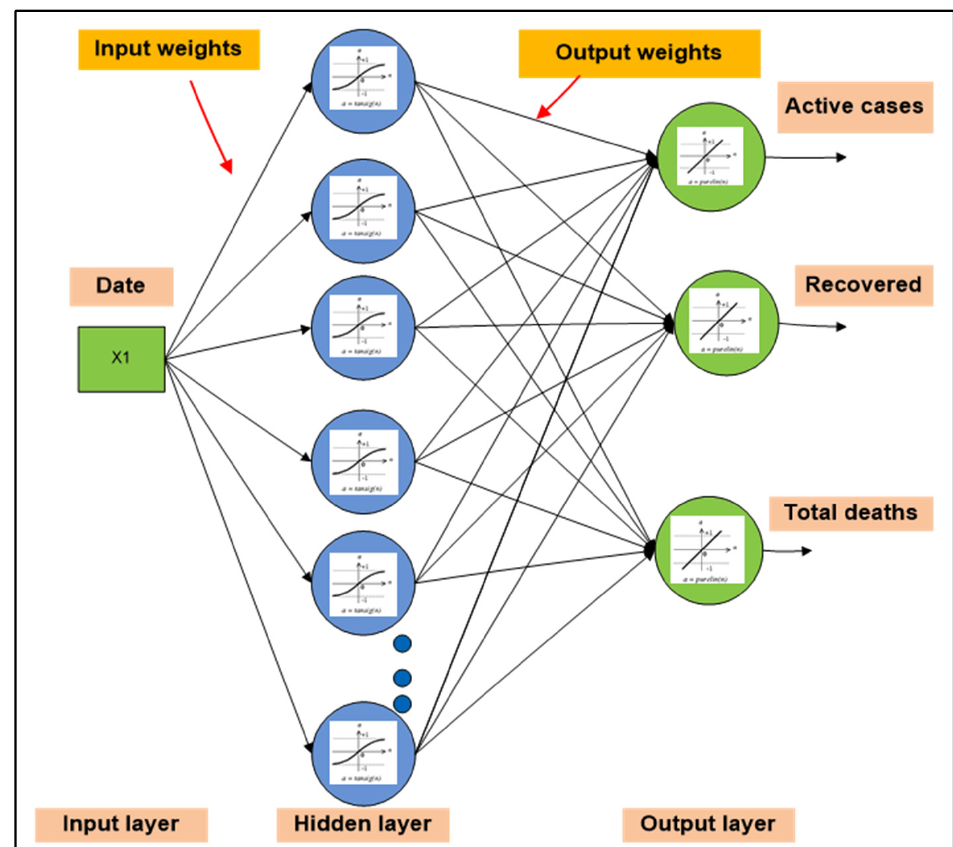
Figure 1. The Structure of the MLPNN that have used for both models (Brazil artificial neural network (ANN) model and Mexico ANN model).